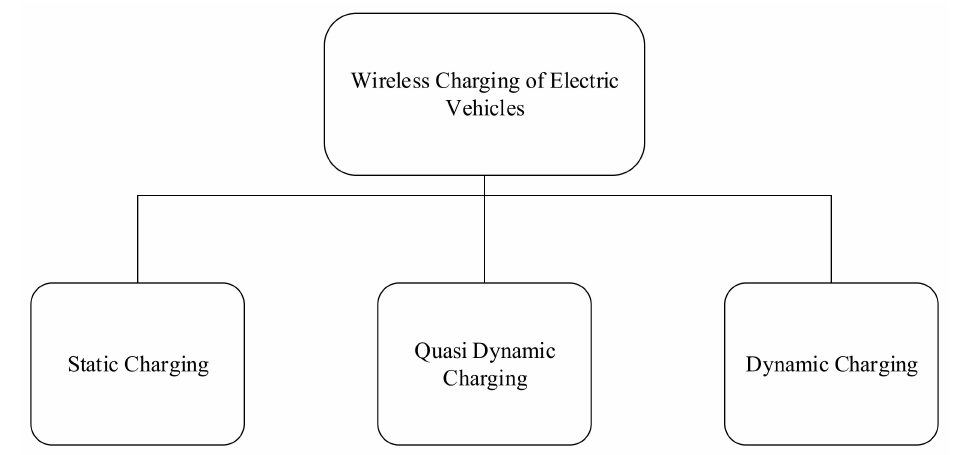
Figure 1. Wireless charging methods for